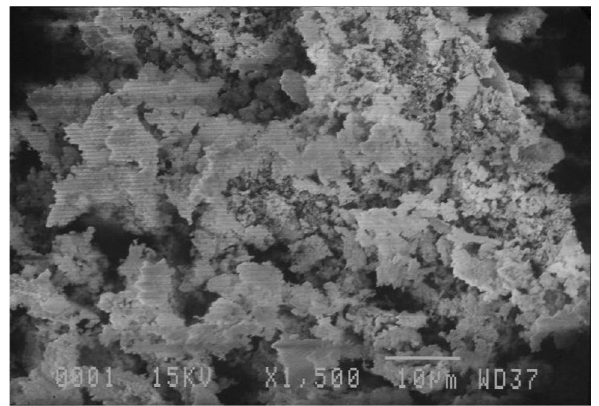
Fig. 1 SEM image of the used cigarette filter ash